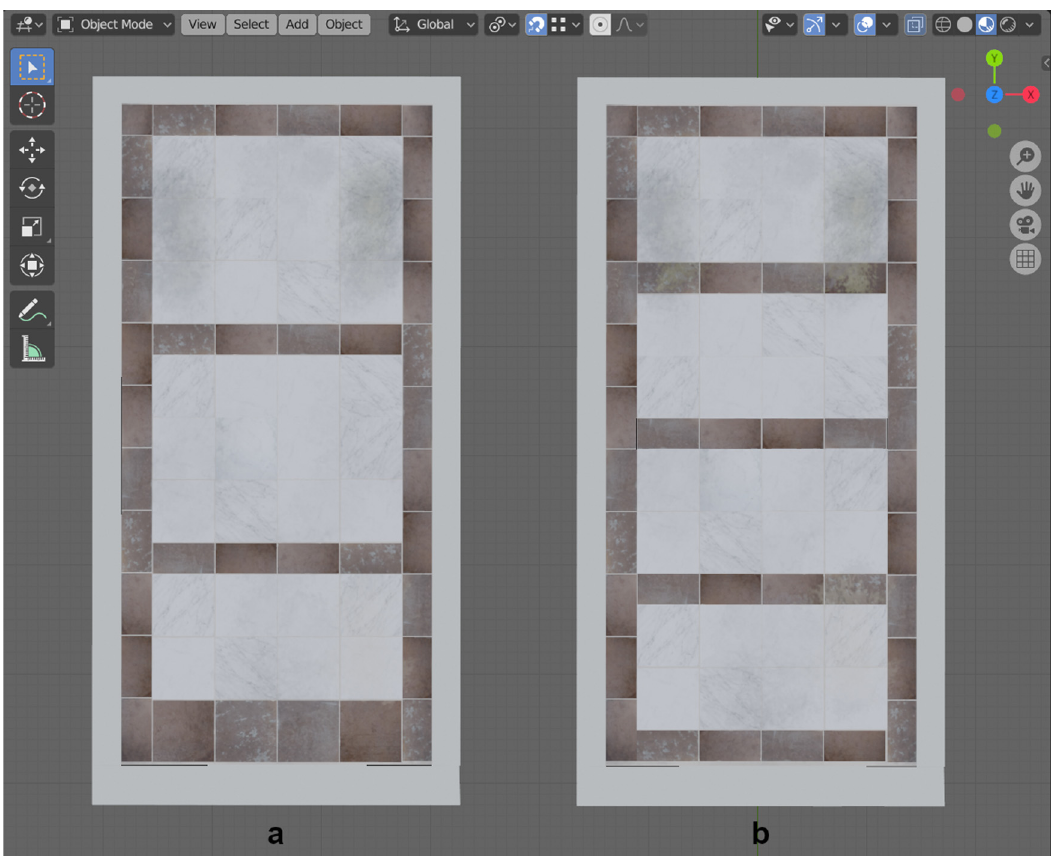
Figure 3: Two alternative hypotheses for the reconstruction of the voorhuis ’ fl oor pattern with a total of 20.5 tiles used as red bands corresponding to the number indicated by De Grae ff in his almanacs. In the research environment, users are able to switch between the two alternatives among the options available under the “ Actions ” button ( see Section 4.2 )